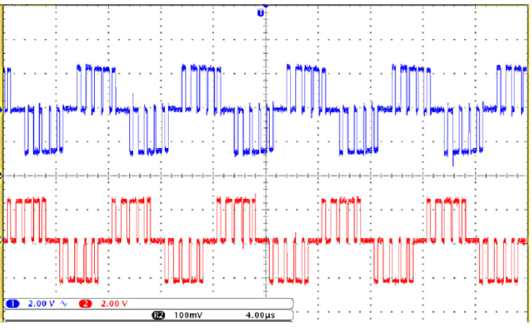
Figure 11. Waveforms of phase voltage.